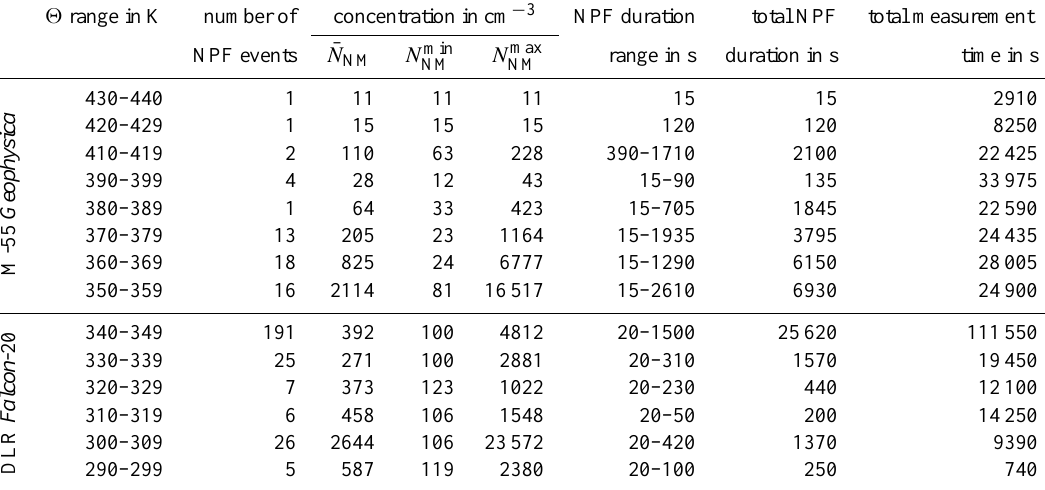
Table 1. Number of occurrences of a total of 68 single NPF events observed aboard the M-55 Geophysica and of 266 single NPF events observed aboard the DLR Falcon-20 as a function of potential temperature. The number concentration N NM is given as the arithmetic mean together with the maximum and minimum value of N NM reached in each 2 -bin. The “NPF duration” is given as range between shortest and longest duration of an event with a total NPF duration for each 2 -bin. The total measurement time reflects the residence time of the two aircraft in each 2 -bin throughout the TROCCINOX and SCOUT-AMMA